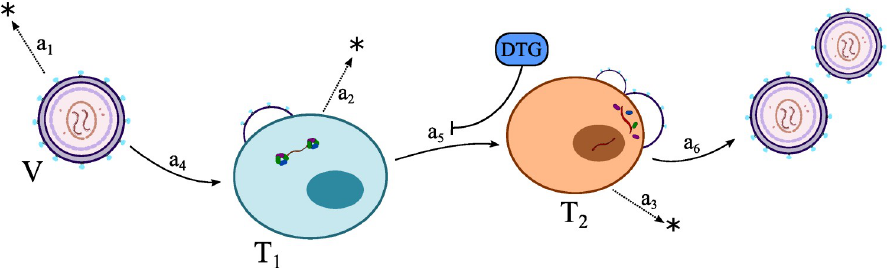
Fig 1. Schematic of the utilized viral dynamics model. V, T 1 , T 2 denote virus, early infected T-cells and productively infected T-cells respectively. Each reaction is denoted by its reaction propensity a 1 − a 6 . Briefly, a free virus can either be cleared (with reaction propensity a 1 ), or infect a susceptible T cell with rate a 4 to yield an early infected cell T 1 . These cells denote a state where the virus has penetrated the host cell, but has not yet integrated its proviral DNA into the host cell’s genome, thus not yet producing viral offspring. Early infected cells T 1 can either be cleared with rate a 2 or the proviral DNA irreversibly becomes integrated into the host cells DNA with rate a 5 to yield a productively infected T-cell T 2 . T 2 cells start producing infectious progeny virus with rate a 6 , or they may get cleared by the immune system with rate a